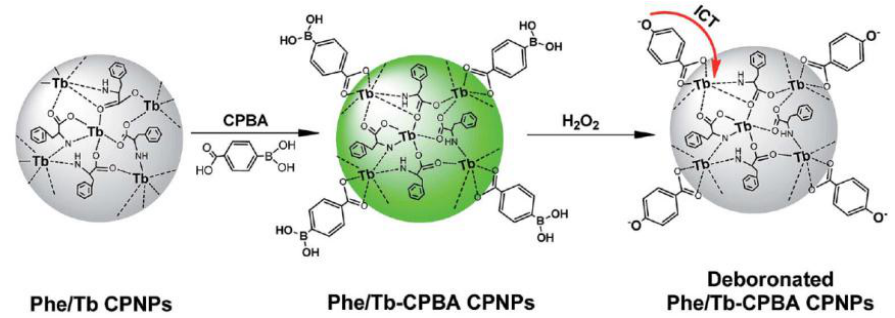
Figure 6. Luminescence response of lanthanide coordination polymer nanoparticles to H 2 O 2 . Reproduced from [21] with permission of The Royal Society of